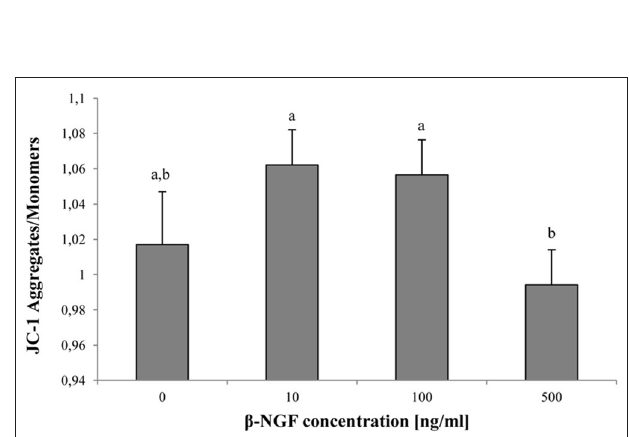
Data are expressed as median ± standard error. a , b , c Within columns, different letters between rows indicate significant differences (p < 0.05, n = 11 per group).